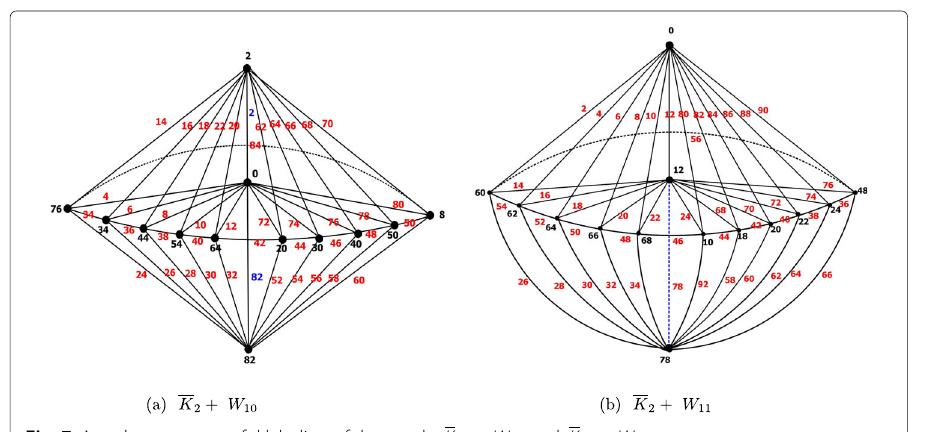
Fig. 7 An edge even graceful labeling of the graphs K 2 + W 10 and K 2 + W